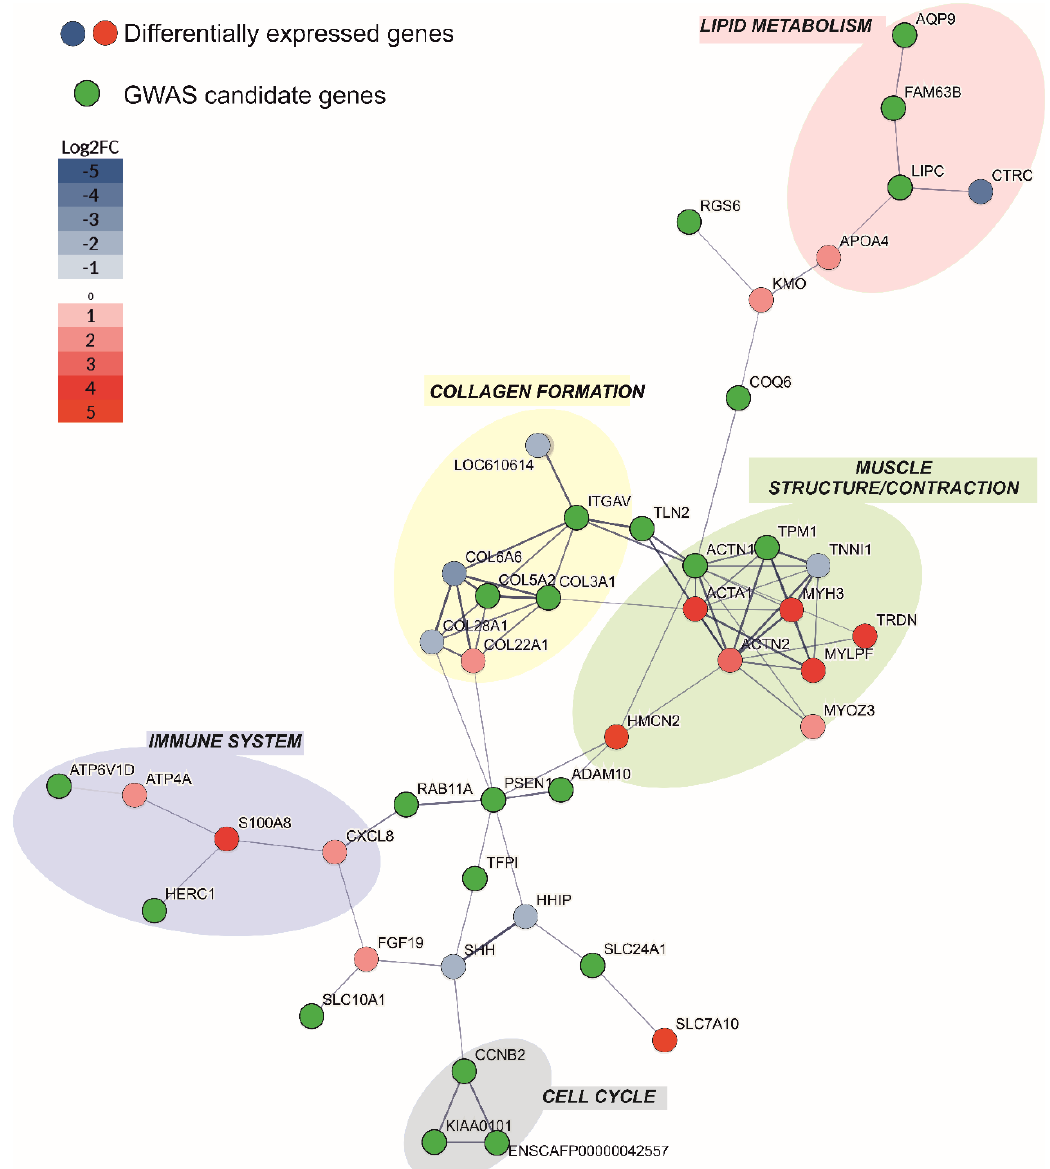
Figure 5. Interactions of GWAS candidate genes (green) and STRING-associated strongly differentially expressed genes colored by their level of expression. We used only medium confidence associations and higher (increasing thickness of lines connecting genes indicates greater confidence). Colorful bubbles represent the metabolic pathways common for each cluster of